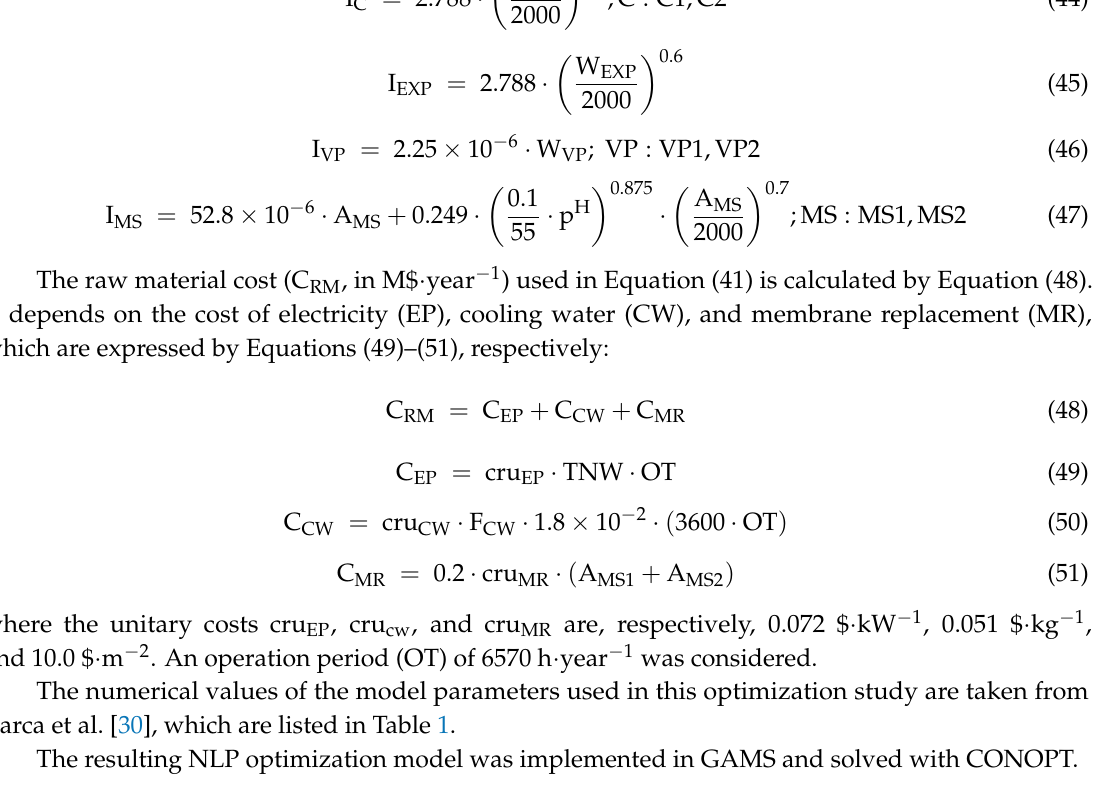
Table 1. Numerical values of model parameters